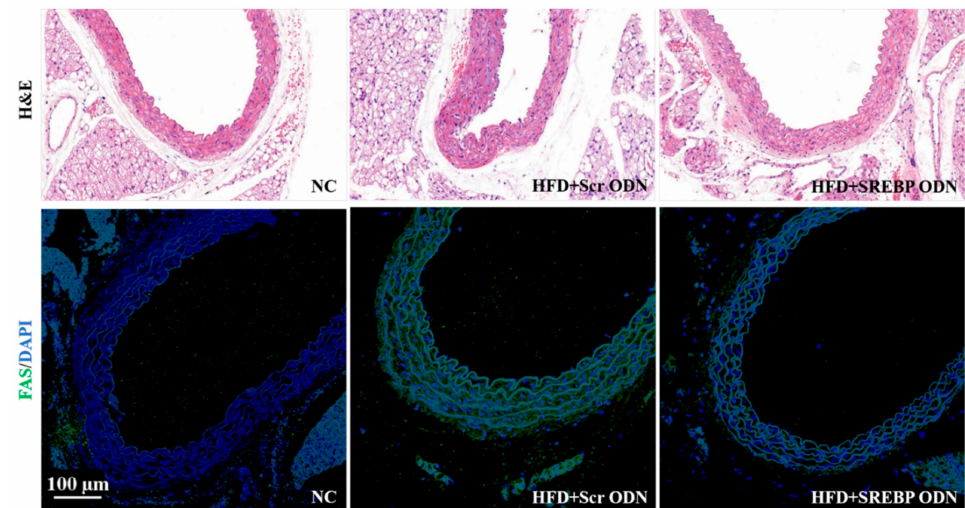
Figure 5. SREBP decoy ODN suppresses HFD-induced aorta damage. Histological section of murine aortas stained with H&E ( upper panel ) and immunofluorescence staining ( lower panel ) ( n = 6). H&E staining show that changes were attenuated in the SREBP decoy treated group. Immunofluorescence staining results show that SREBP decoy ODN inhibits expression of FAS. Representative images from each group. Scale bar = 100 µ m. NC, normal control group; HFD + Scr ODN, HFD fed group